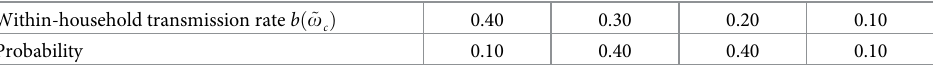
Table 3. The discrete probability distribution represents the within-household transmission rate ( b ) used in this study.